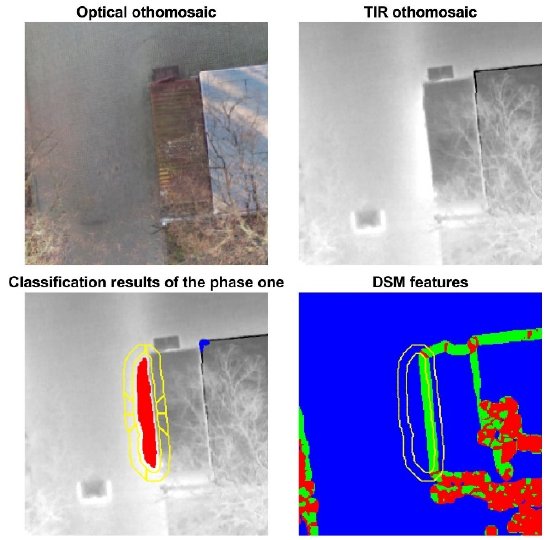
Figure 6: Feature selection - example of the a false alarm: thermal anomaly candidate close to a building. The bottom right image shows the description of height variations: area regions are marked in blue, line regions in green and point regions in